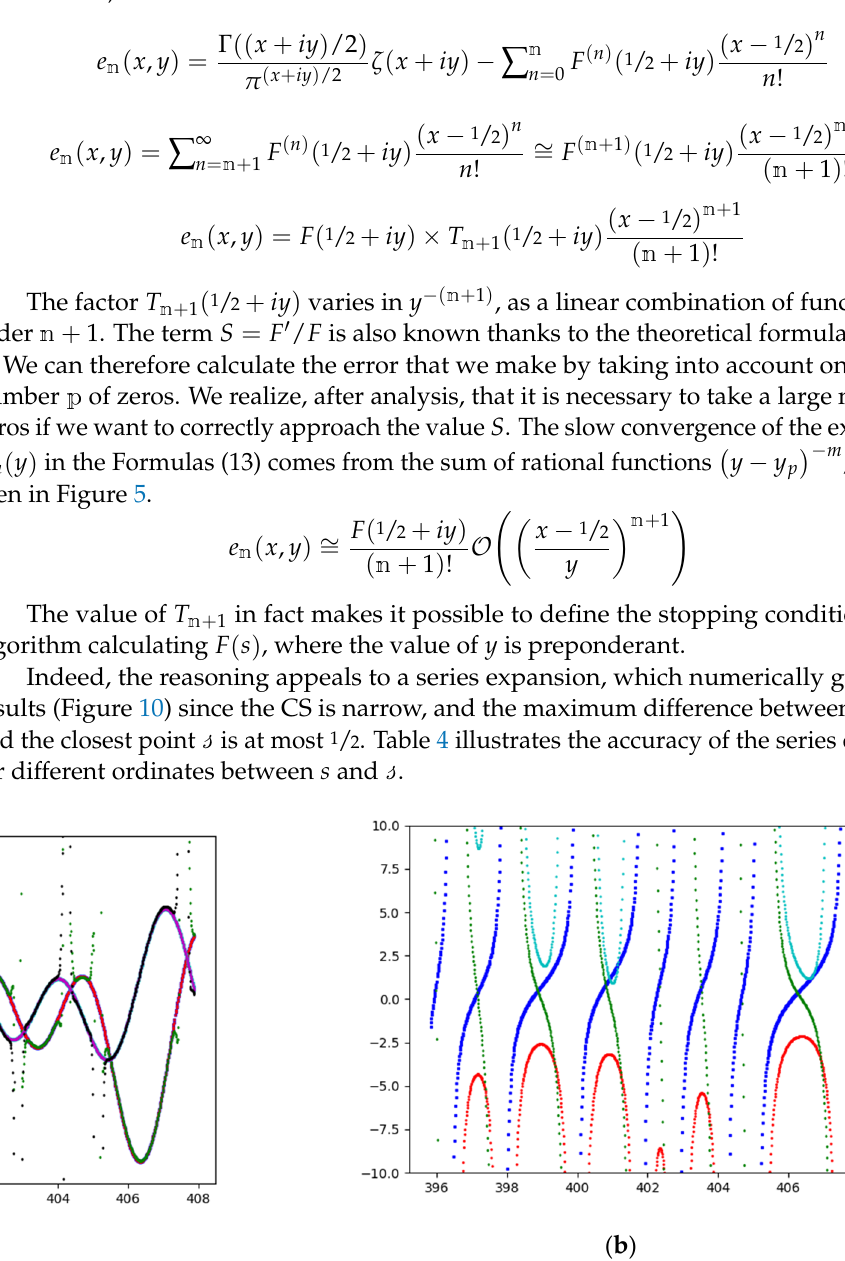
Figure 10. ( a ) Direct and indirect estimates of F in comparison with the true value of F : we observe that (cid:60) ( F ) and (cid:61) ( F ) never intersect at zero together. We observe the ‘fairy chimneys’, which are artefacts of the numerical calculation. ( b ) S 1 (blue), S 2 (red), S 3 (green), S 4 (cyan) curves along y for x = 0.05 : S 2 and S 4 do not cross the zero ordinate. S 2 is always negative.